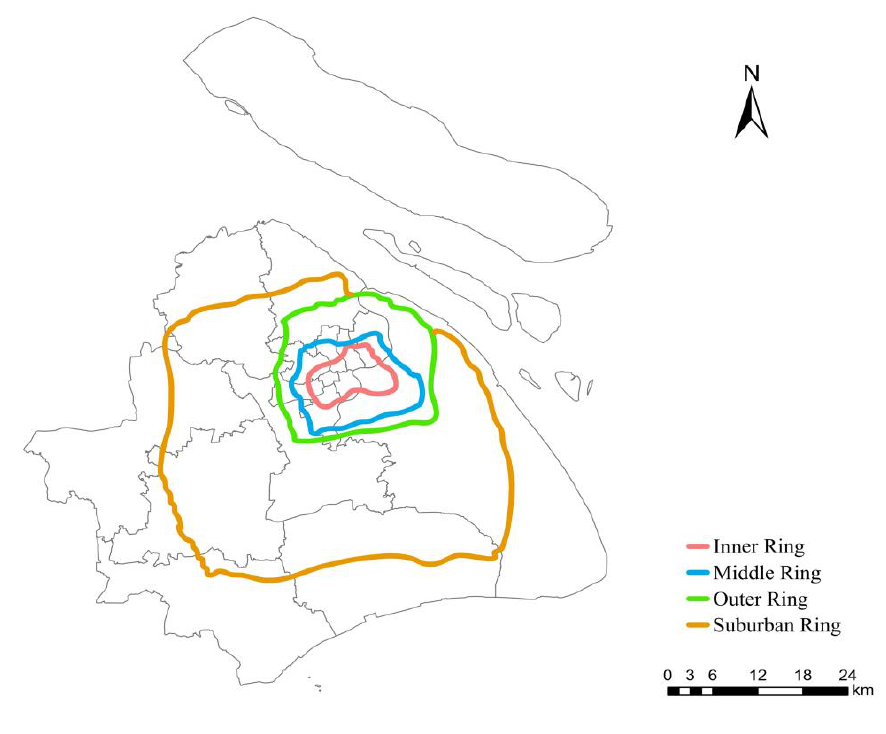
Figure 5. Inner, middle, outer and suburban rings in Shanghai.